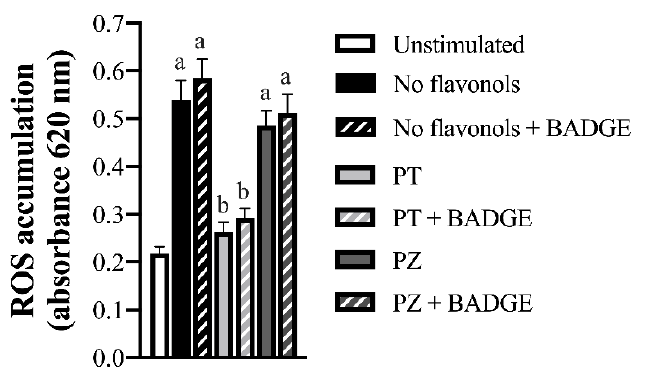
Figure 5. Cellular reactive oxygen species (ROS) accumulation in LPS + CoCl 2 -stimulated adipocytes co-treated with PT or PZ, with or without BADGE. Values are means ± SEM; n = 9/treatment. Data were analyzed by two-way ANOVA and means without a common letter differ within cultures treated ± BADGE, p < 0.05.